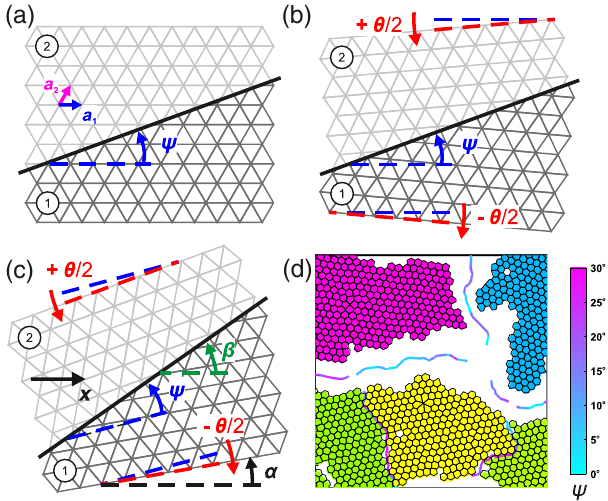
FIG. 8. (a) Definition of the GB inclination ψ from the GB line (black line) in the starting lattice. (b) Construction of the GB by the rotation of grains ① and ② by ∓ θ = 2 , where θ is the misorientation. (c) Schematic view of a GB as encountered in an experiment, where α is the orientation of grain ① and β the tangent direction of the GB with respect to the reference x -axis. (d) Similar view as in Fig. 7(d) with the GB segments colored according to their inclination as indicated by the color